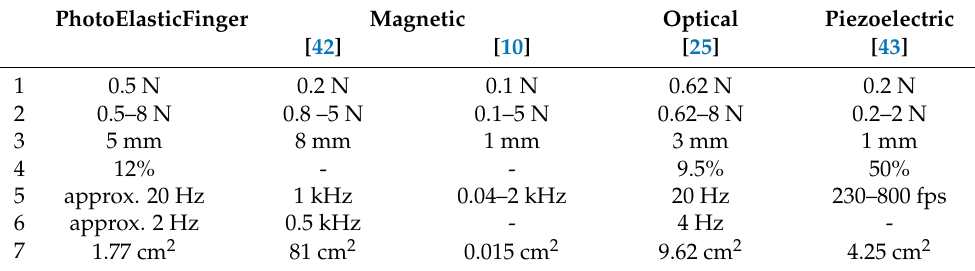
Table 1. Characteristics of the developed PhotoElasticFinger sensor in comparison with